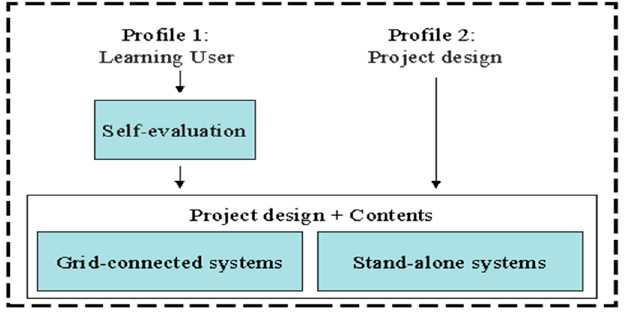
Figure 1. Simplified scheme of the structure of the PVLEARNING platform.